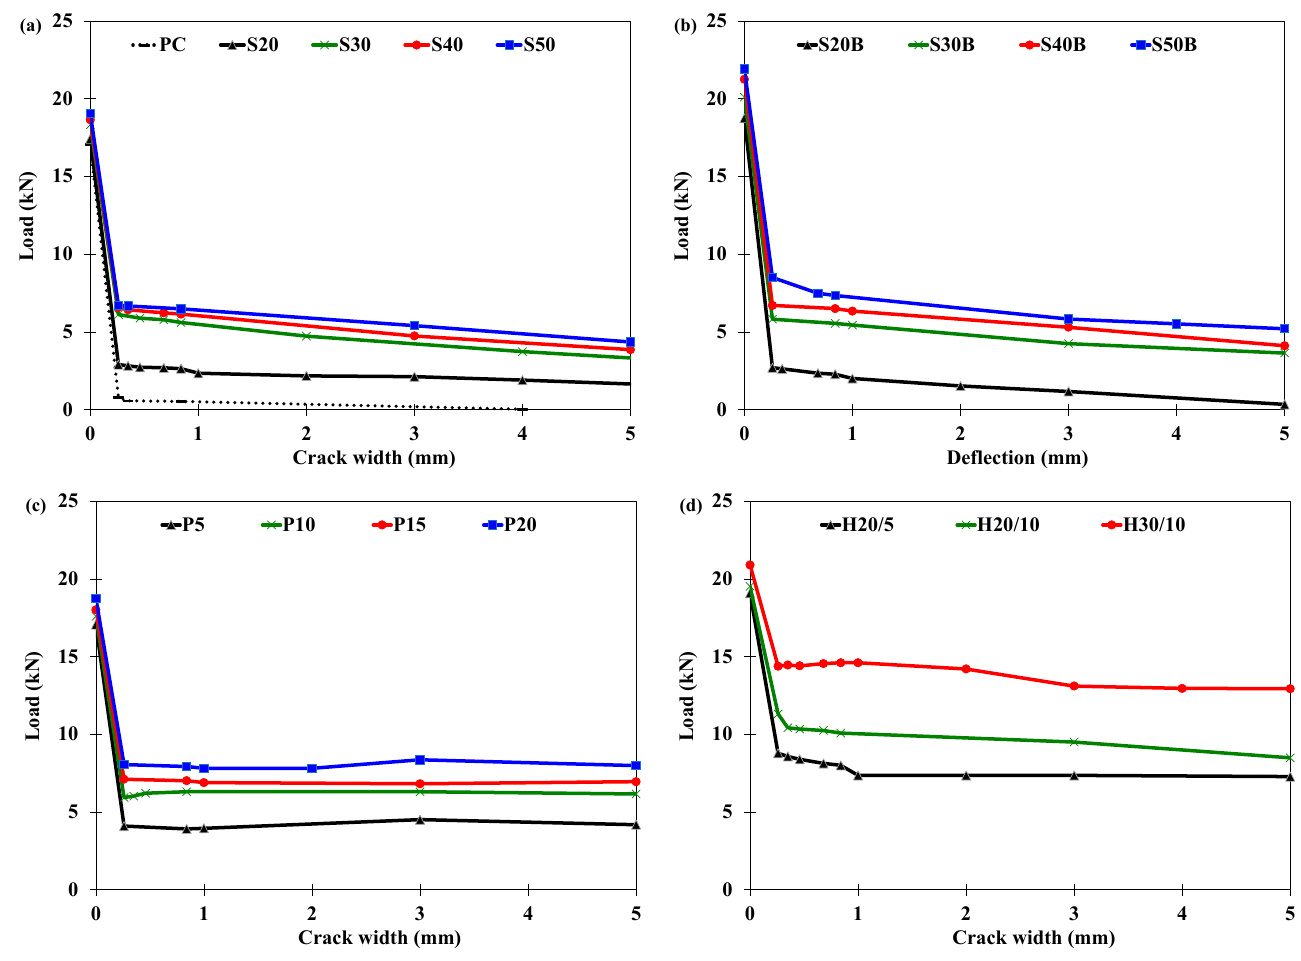
Figure 11. Load vs. crack width recorded at discrete points during the testing for specimen incorporating ( a ) straight steel fibers, ( b ) bundled steel fibers, ( c ) PP fibers, ( d ) hybrid fibers (bundled steel fibers and PP fibers).